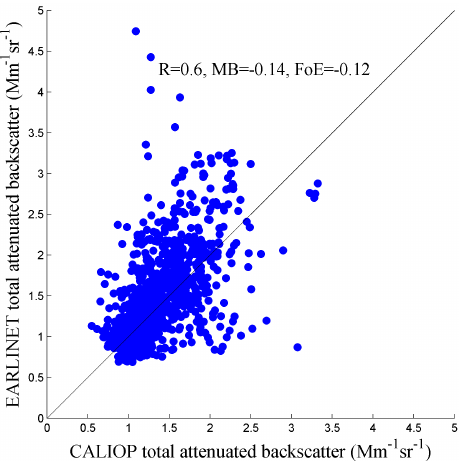
Figure 10. CALIOP vs. EARLINET total attenuated backscatter for CALIOP overpasses over EARLINET stations only for PBL. The plot includes all data points for overpasses without layers present in both the PBL and the FT.